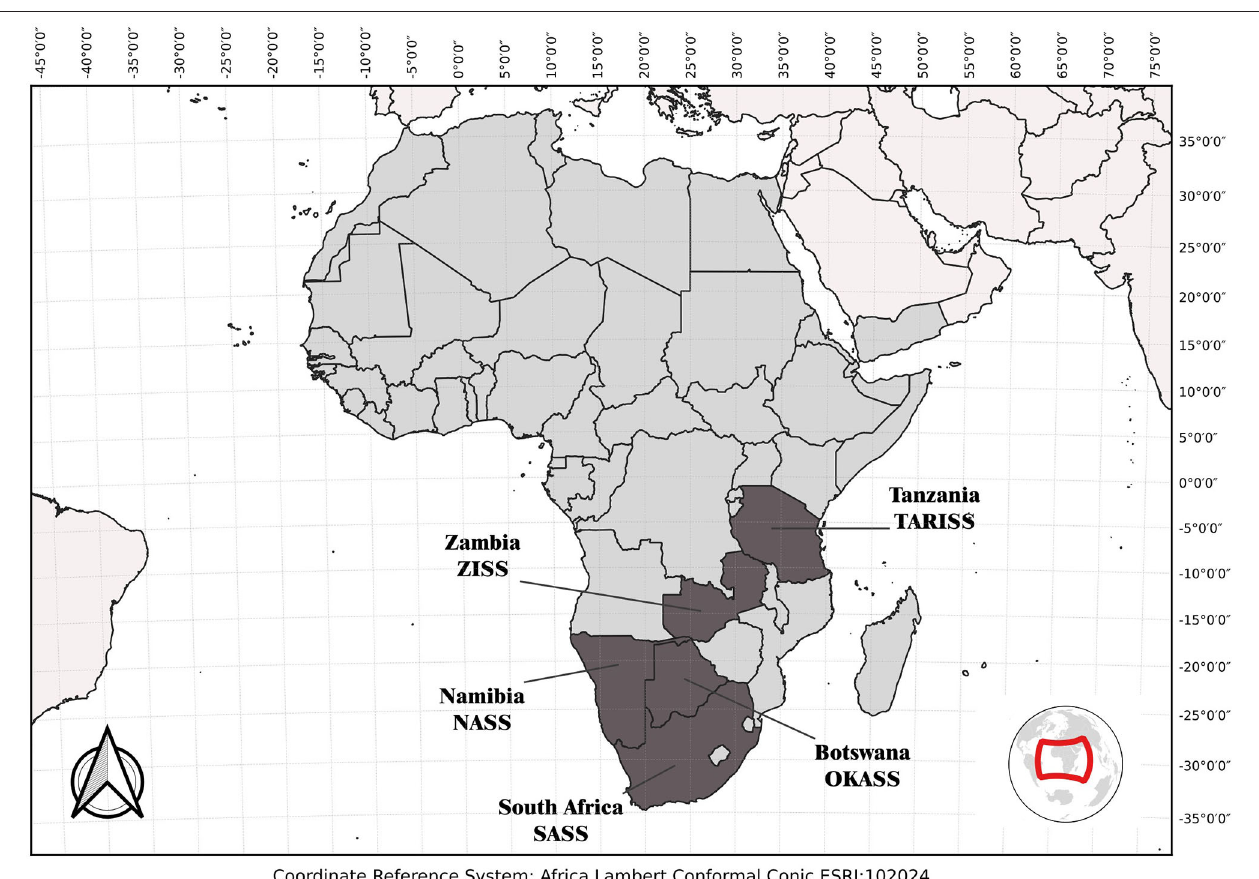
FIGURE 1 | Rapid bioassessment protocols developed in Africa including the South African Scoring System (SASS; Dickens and Graham, 2002), the Namibian Scoring System (NASS; Palmer and Taylor, 2004), the Okavango Assessment System (OKASS; Dallas, 2009), the Tanzania River Scoring System (TARISS; Kaaya et al., 2015), and the Zambian Invertebrate Scoring System (ZISS; Dallas et al.,